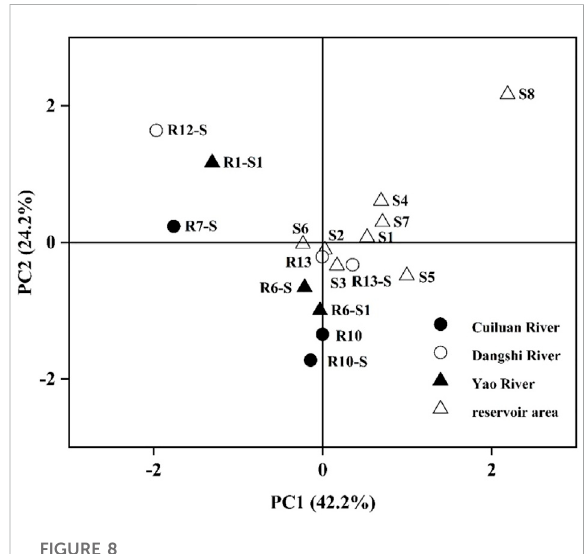
FIGURE 8 PrincipalcomponentanalysisofFefractionsinsedimentsand surrounding soils of the Xishan Reservoir drainage area.